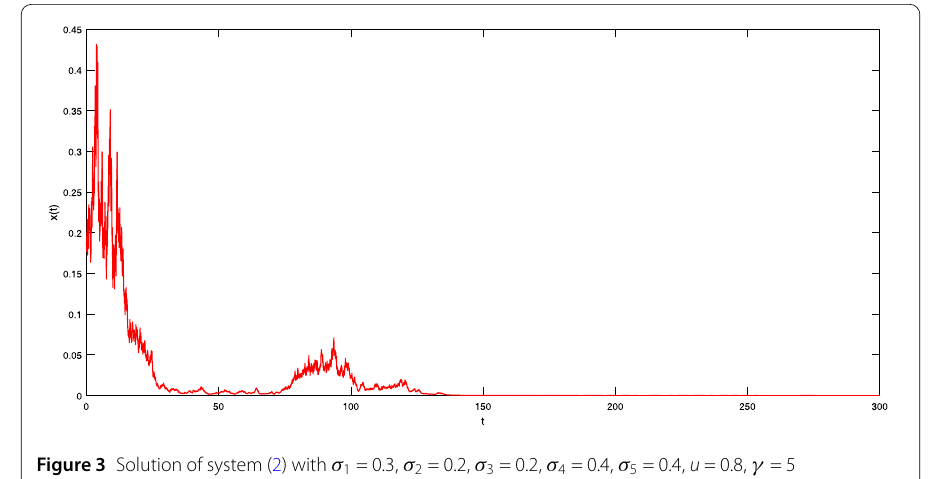
Figure 3 Solution of system (2) with σ 1 = 0.3, σ 2 = 0.2, σ 3 = 0.2, σ 4 = 0.4, σ 5 = 0.4, u = 0.8, γ = 5